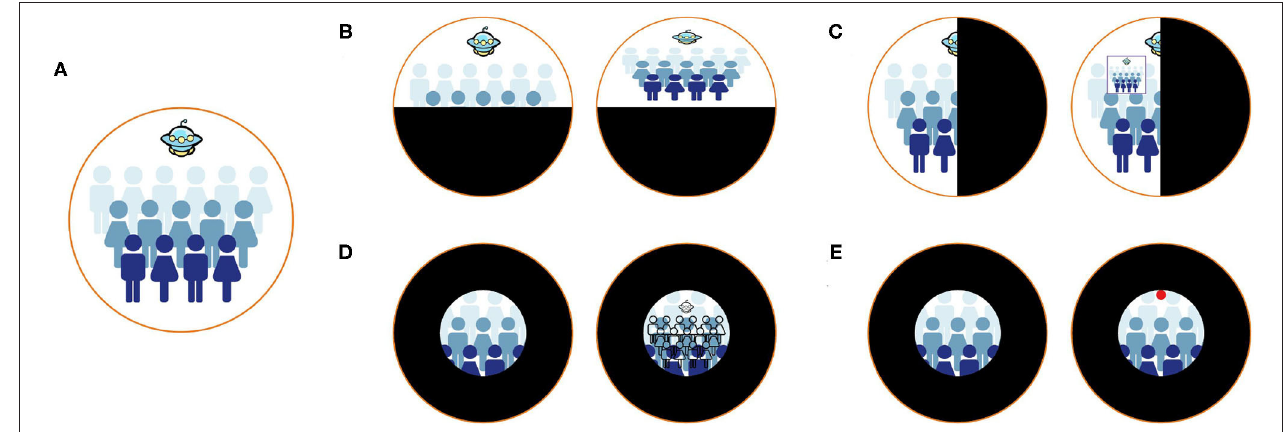
FIGURE 2 | Different methods to aid patients with visual field defects. (A) Healthy vision. (B) The remapping method (10). Patients with visual field defects cannot see the entire scene. After remapping, patients can see the entire scene in their residual visual field. (C) The method of overlaying the overview window (15). After overlaying an overview window, patients can perceive the entire scene and natural vision simultaneously. (D) The method of using visual multiplexing (16). Patients can perceive the counter view of the entire scene and natural vision simultaneously. (E) The method of implementing danger indicators ( 17). Patients with tunnel vision cannot notice the danger the Unidentified Flying Object brought. The danger indicators can help patients notice surrounding